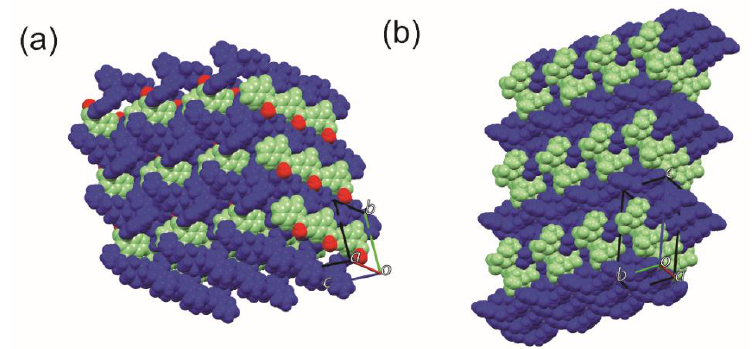
Figure 6. Packing view of ( a ) BEX–SAC and ( b ) BEX–CYM. All molecules are drawn in a space-fill setting. Cationic benexate, anionic salt co-former, and water molecules are represented by dark blue, light green, and red molecules, respectively.